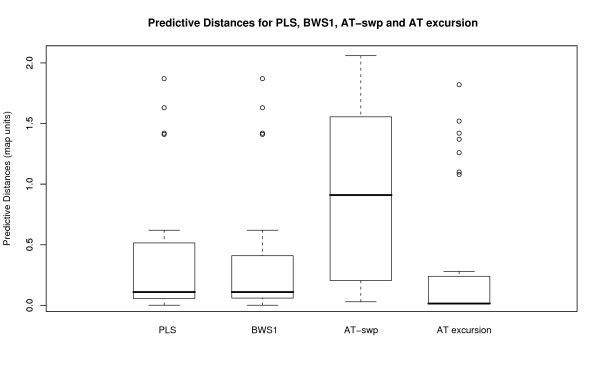
Predictive Distances for PLS, BWS1, AT-swp and AT excursion. These boxplots show the predictive distances for PLS, BWS1, AT-swp and AT excursion.